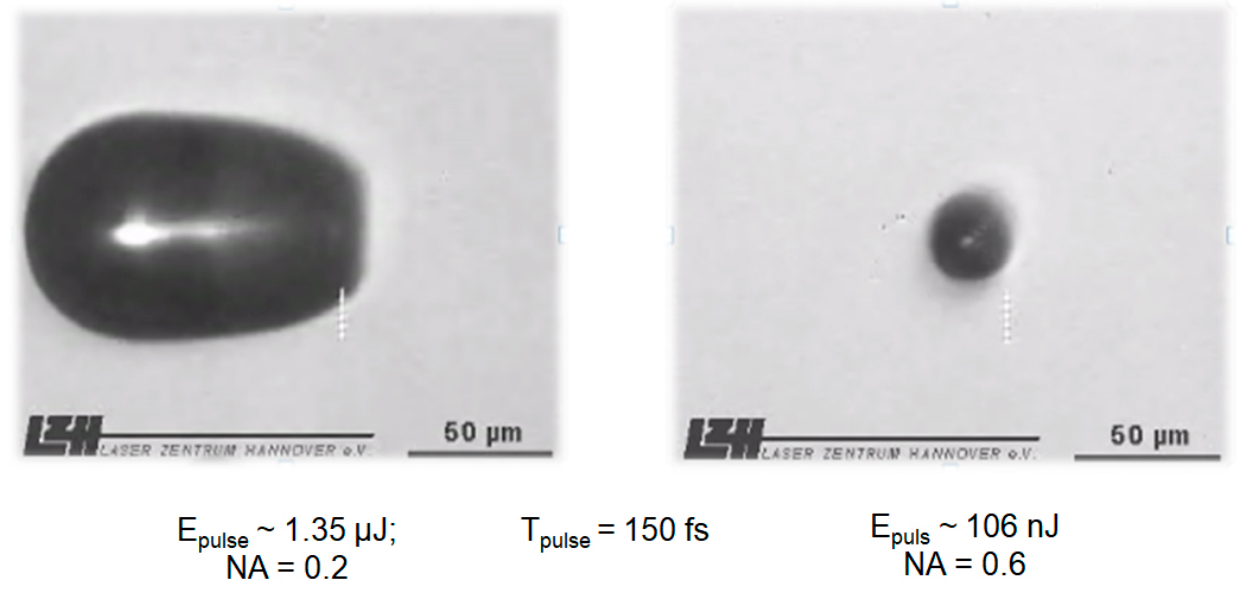
Figure 3. Cavitation in water for different of laser settings.